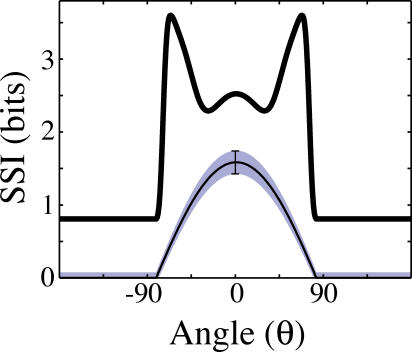
This “Batman” graph shows which stimuli are best encoded by a neuron in a relatively noise-free situation, when the neuron is better at making fine distinctions.